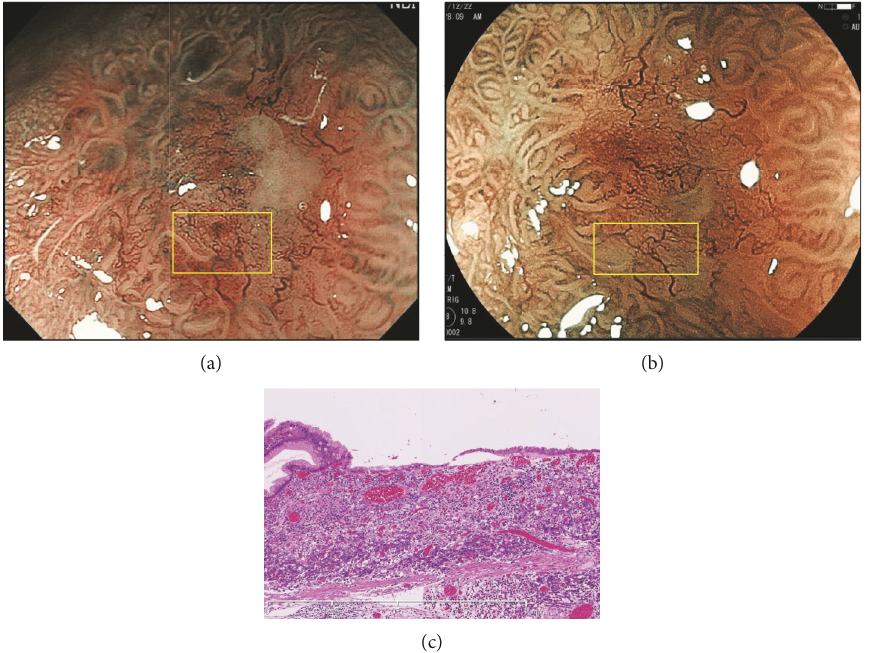
Figure 5: A signet-ring cell carcinoma in group C. (a) MSP was absent on ME-NBI (yellow box). (b) MSP was also absent on ME-BLI (yellow box). (c) Histological view of the yellow box in Figures 5(a) and 5(b). The glandular architecture was destroyed due to in fi ltration of signet-ring cell carcinoma in the entire mucosal